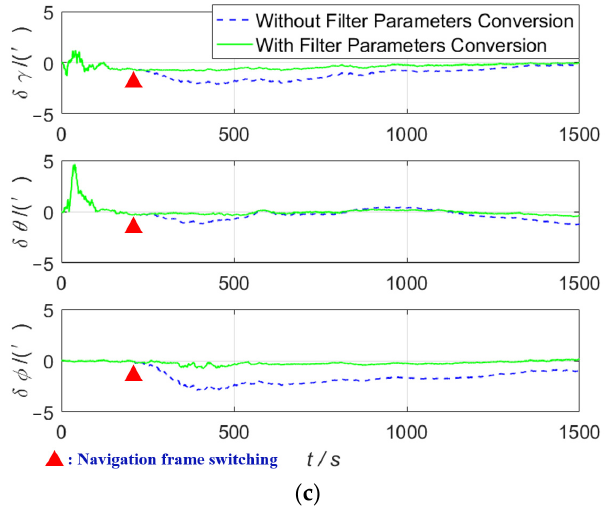
Figure 4. Error curves of the two methods: ( a ) position error curves; ( b ) velocity error curves; and ( c ) attitude error curves.